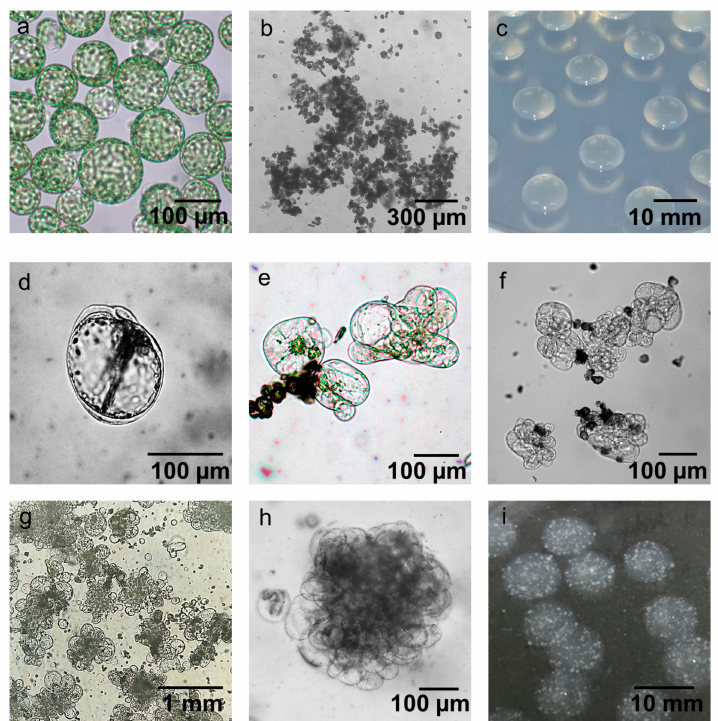
Figure 4. Induction of microcalli from potato protoplasts using an alginate lens. ( a ) Purified individ- ual protoplasts. ( b ) Agglutination of protoplasts through liquid culture. ( c – i ) Fixation of protoplasts in alginate lenses, ( c ) and culture for 3 days ( d ), 5 days ( e ), 7 days ( f ), 2 weeks ( g , h ) and 3 weeks ( i ) for microcalli